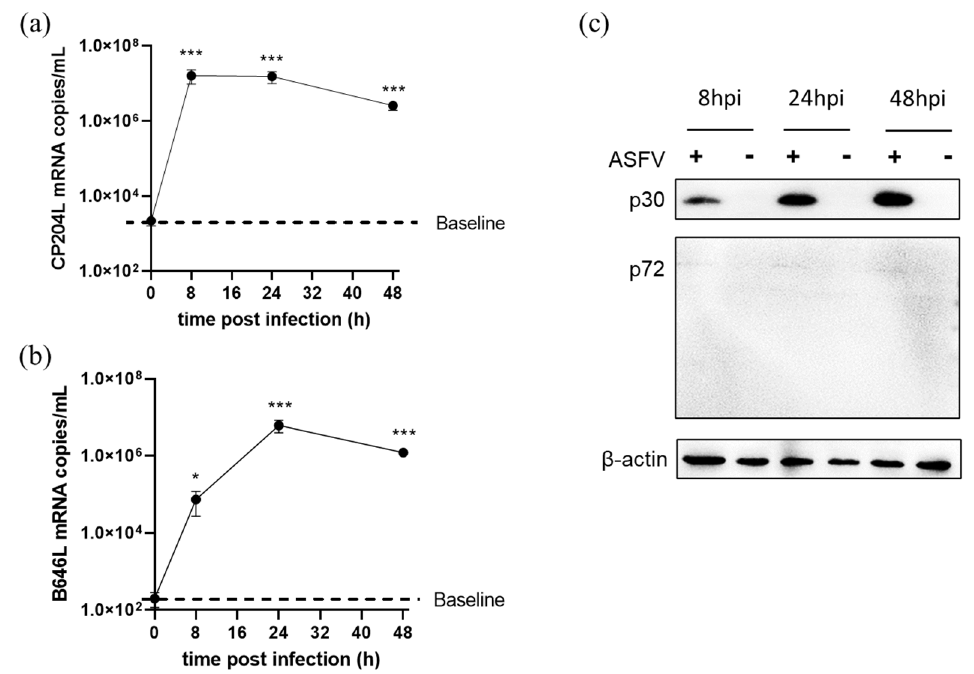
Figure 6. ASFV early and late genes transcription in 3D4/21 cells. The cells were infected with ASFV at 5 MOI for 2 h at 37 ◦ C. After washing with PBS three times and incubation with fresh medium, the total RNAs were extracted from the infected cells at 8, 24 and 48 hpi and used for quantification with real − time RT − PCR. ( a ) Quantification of ASFV early gene CP204L mRNA. ( b ) Quantification of ASFV late gene B646L mRNA. ( c ) Expressions of the viral p30 and p72 proteins in ASFV − infected 3D4/21 cells detected by western blot. *, p < 0.05; ***, p < 0.005. +: ASFV infected; − : mock.